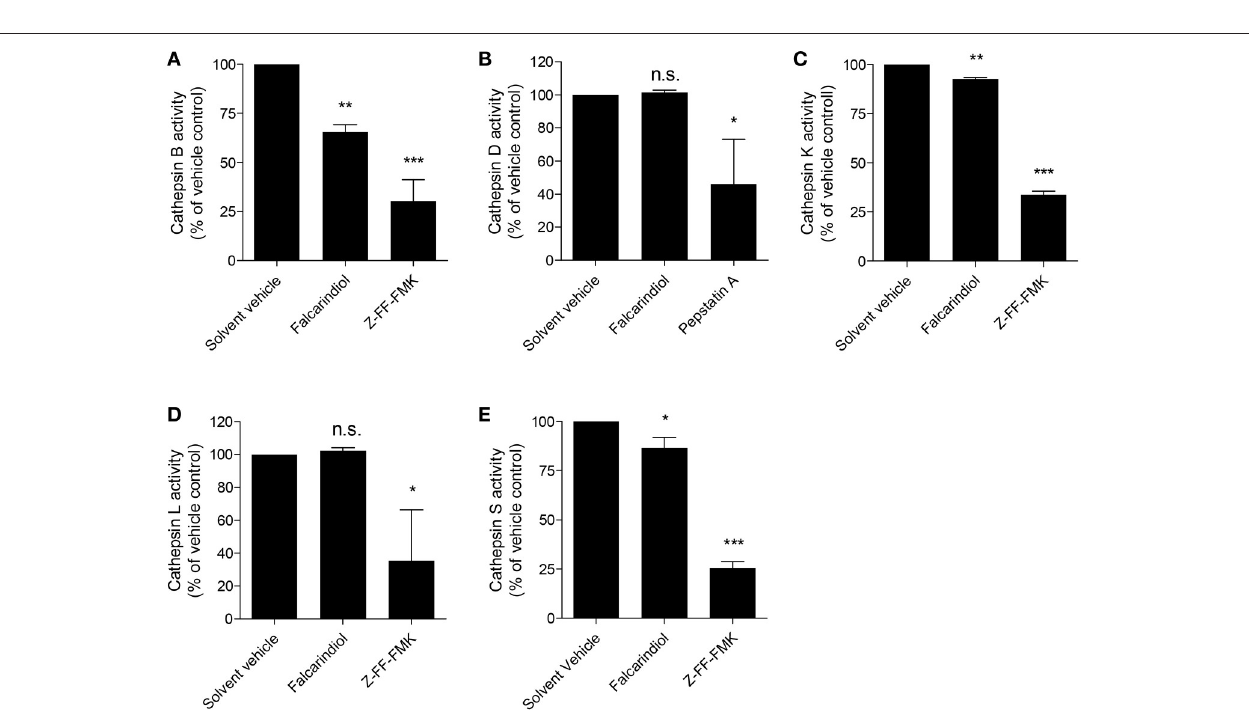
FIGURE 6 | Falcarindiol inhibits several lysosomal cathepsins. (A–E) Differentiated THP-1 macrophages were incubated for 24 h with or without falcarindiol (10 µ M). Cells were lysed and cathepsin activity (S, B, L, K, and D) was determined by fluorescence measurements. Irreversible inhibitors of cathepsin B, S, L, and K (Z-FF-FMK; 1 µ M) and cathepsin D (pepstatin A; 10 µ M) were used as positive controls and directly added to the control lysates. All data are mean ± SD ( n = 3) and vs. solvent vehicle control (DMSO): * p < 0.05, ** p < 0.01, *** p < 0.001, n.s. not significant (one